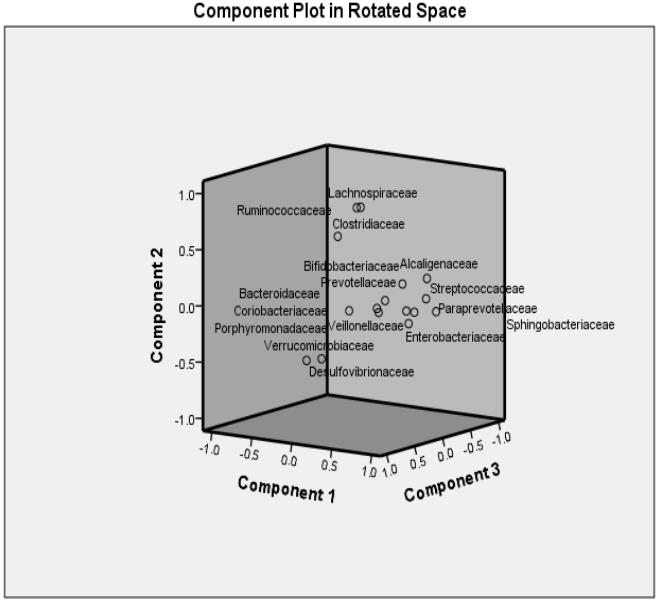
Fig. 1a. Spatial representation of relationships between derived factors and bacteria-family-groups among T2DM.